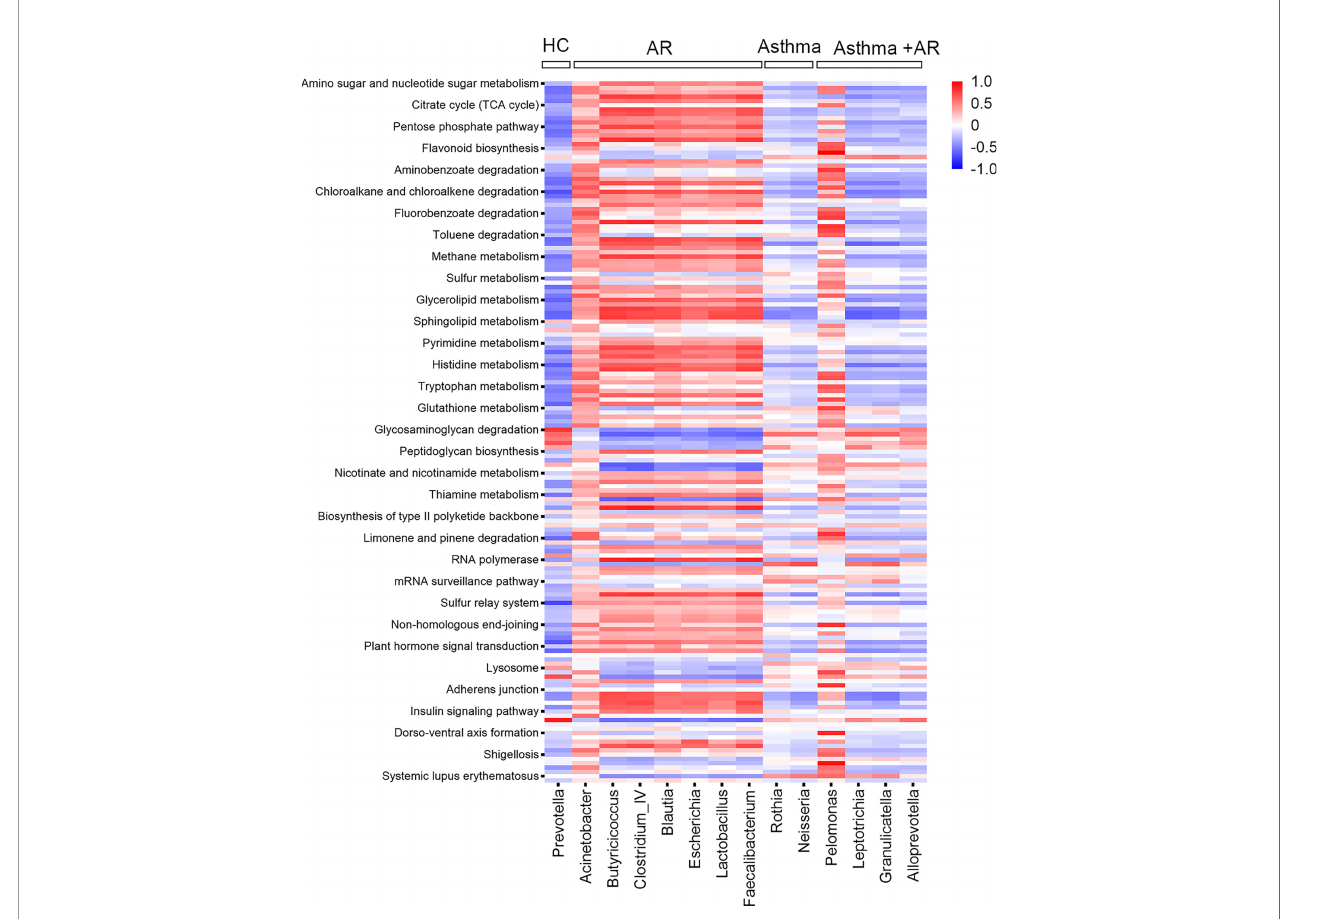
FIGURE 4 | Pearson correction heat maps of predicted KEGG orthologs (KOs) and nasal bacterial taxa among AR, asthma, combined asthma+AR and healthy controls. Blue indicates negative correlations, and red indicates positive correlations. AR, allergic rhinitis; HC, healthy